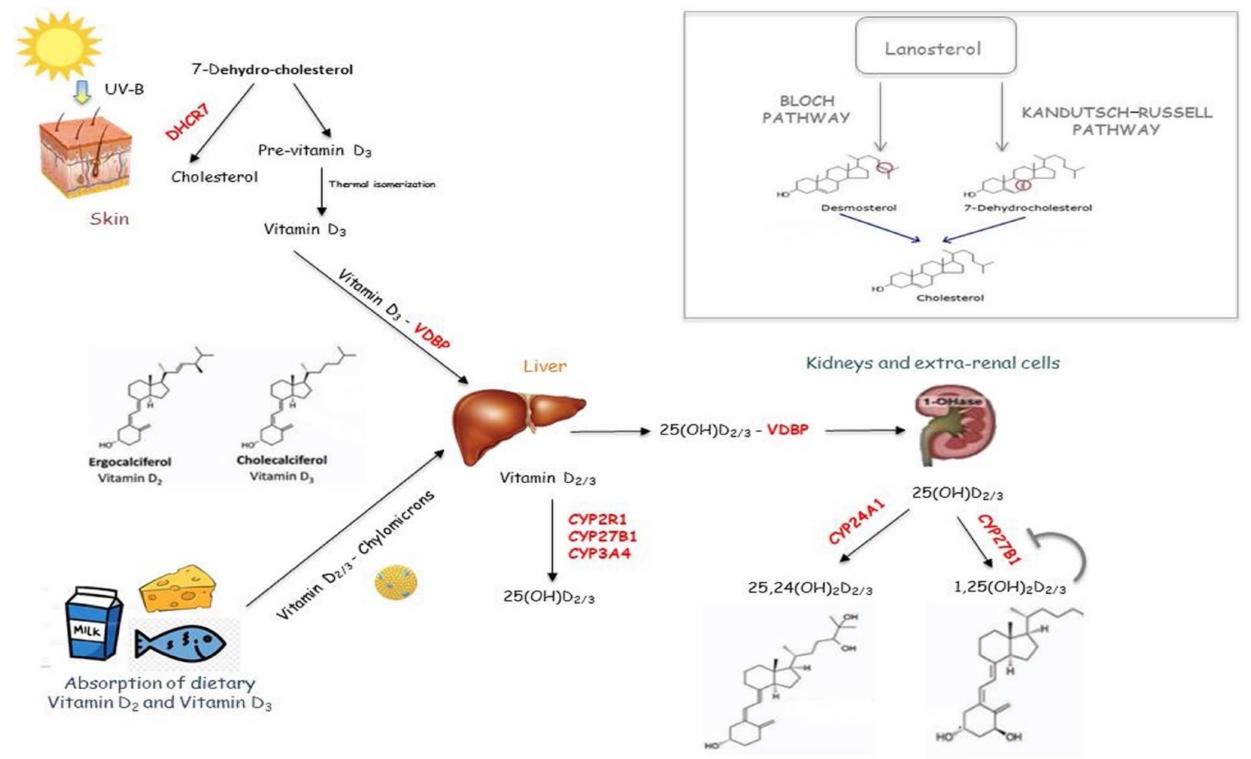
Figure 1. Vitamin D metabolism pathway. Vitamin D active form is produced in a multi-step process, including the ultraviolet B (UVB) rays’ irradiation of a cutaneous precursor [7-dehydro-cholesterol (7-DHC)], and two hydroxylation steps. In addition to the synthesis of Vitamin D, 7-DHC can be oriented toward the production of cholesterol by Kandutsch–Russell biochemical